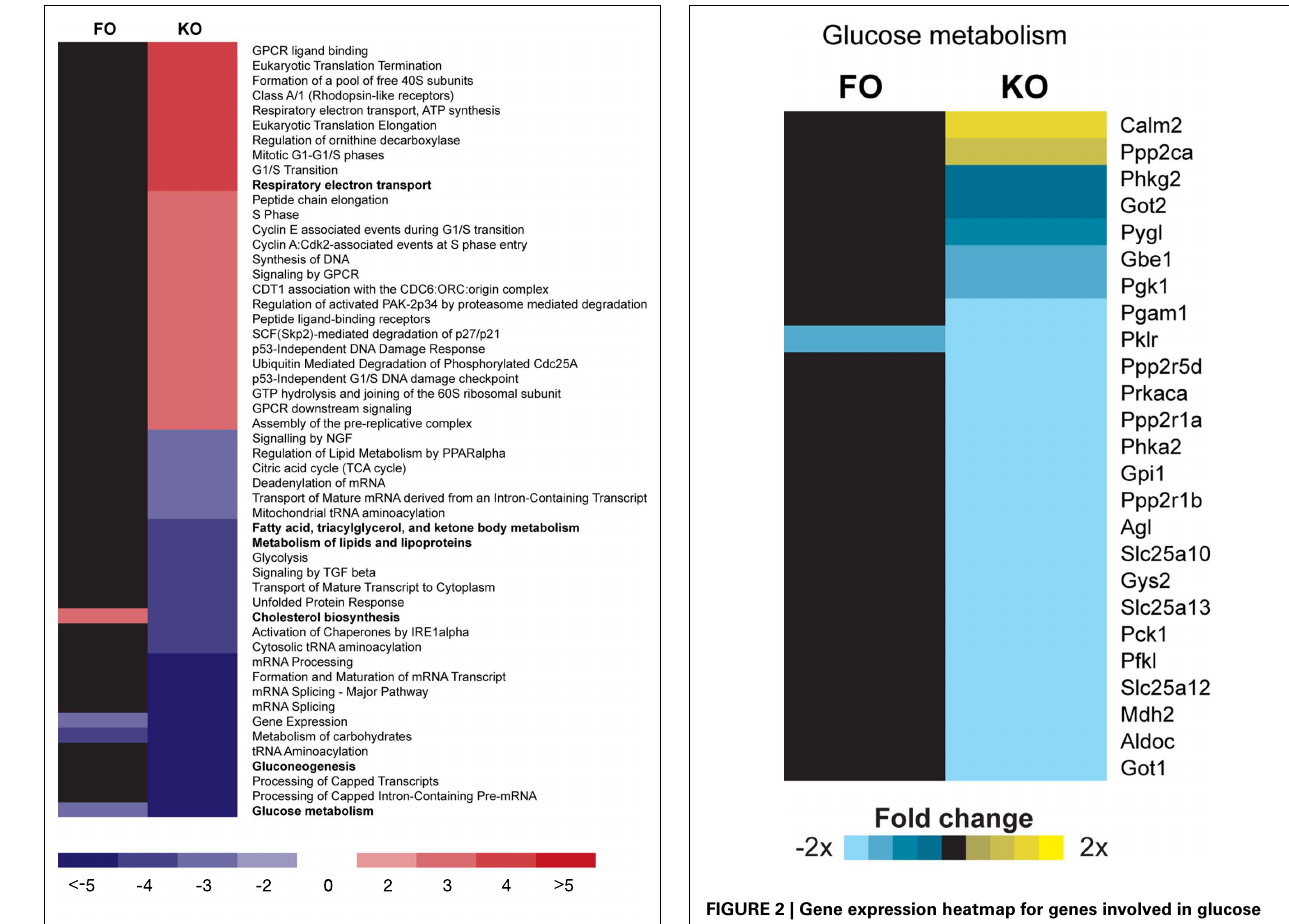
FIGURE 2 | Gene expression heatmap for genes involved in glucose metabolism. PAGE analysis showed a statistically significant effect of fish oil (FO) and krill oil (KO) on the Reactome pathway “Glucose metabolism.” All genes annotated in this pathway and changed in expression by at least one treatment are shown.Two-tailed t -tests were used to determine significant changes at p < 0.01 between treatment and the Control